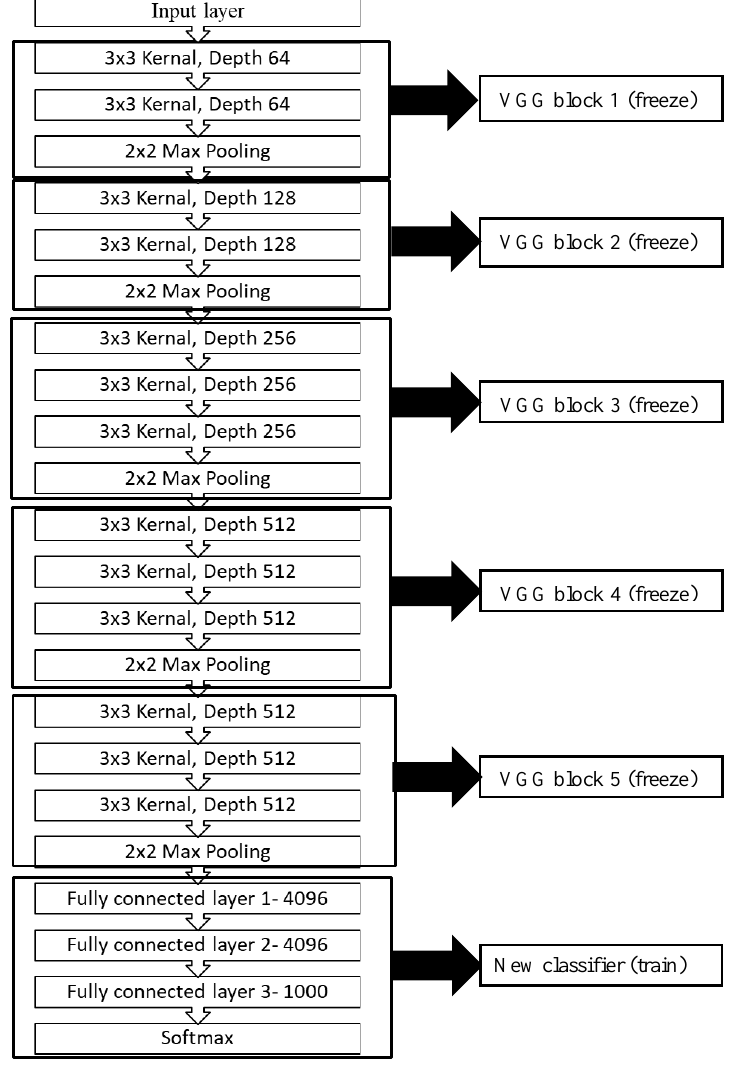
Figure 1. VGG-16 fine